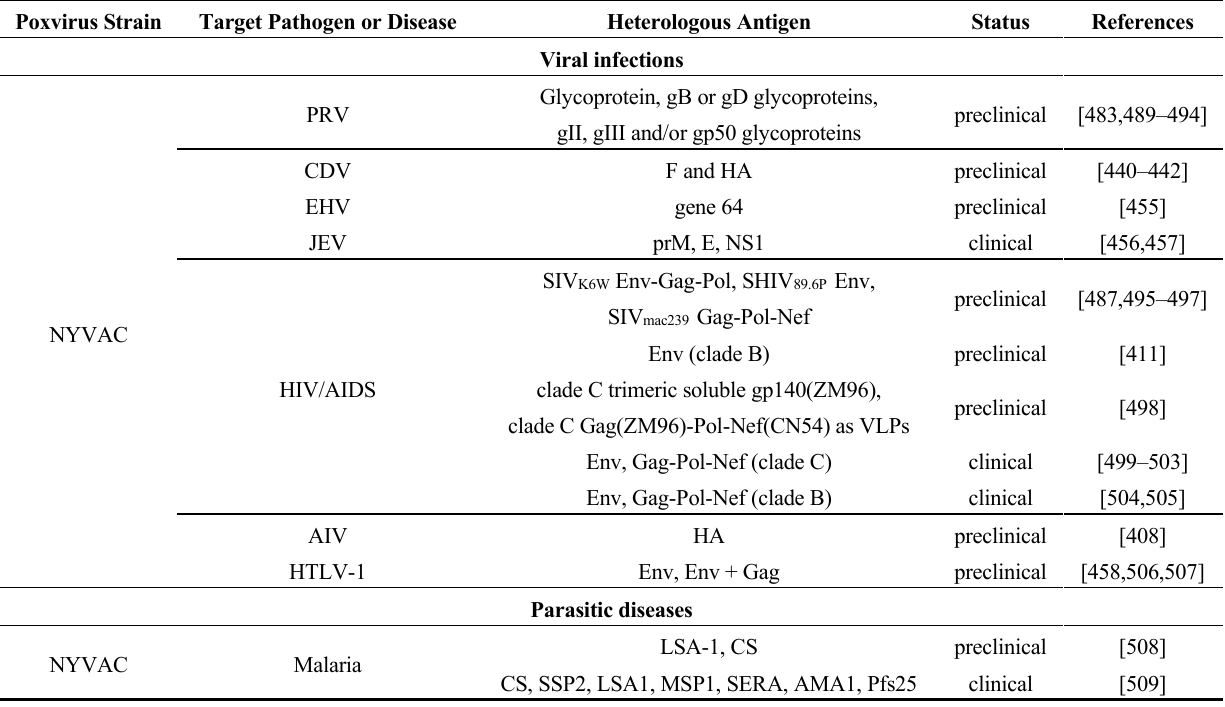
Table 8. Vaccine applications of fourth-generation poxvirus-based vectors generated by the deletion of poxviral